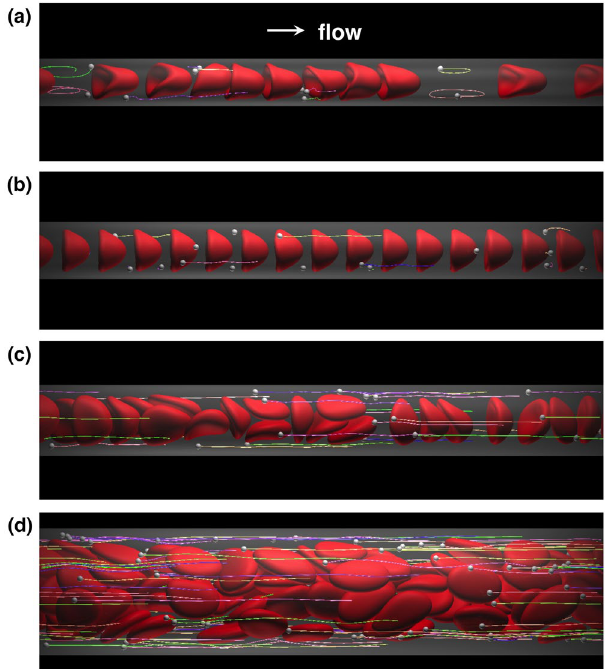
Figure 1. Snapshots of the flow of MPs and RBCs for Hct = 0.2 and Ca = 0.2 in microvessels with diameters ( a ) D = 8 μ m, ( b ) 10 μ m, ( c ) 12 μ m, and ( d ) 22 μ m. The flow is from left to right. Lines show particle trajectories. See also Supplemental Movies S1 to